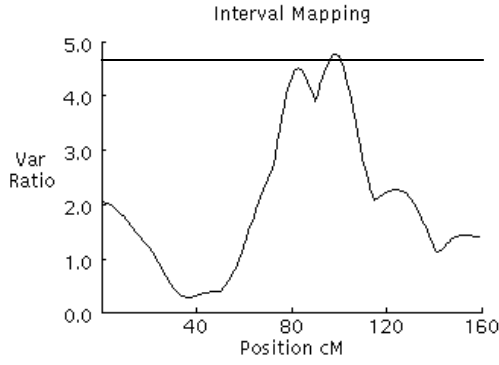
Figure 1. F-ratio curves for body fat on chromosome 6. The x-axis indicates the relative position on the linkage map. The y-axis represents the F-ratio. The horizontal line indicates the 5% chromosome-wide significance level from the permutation